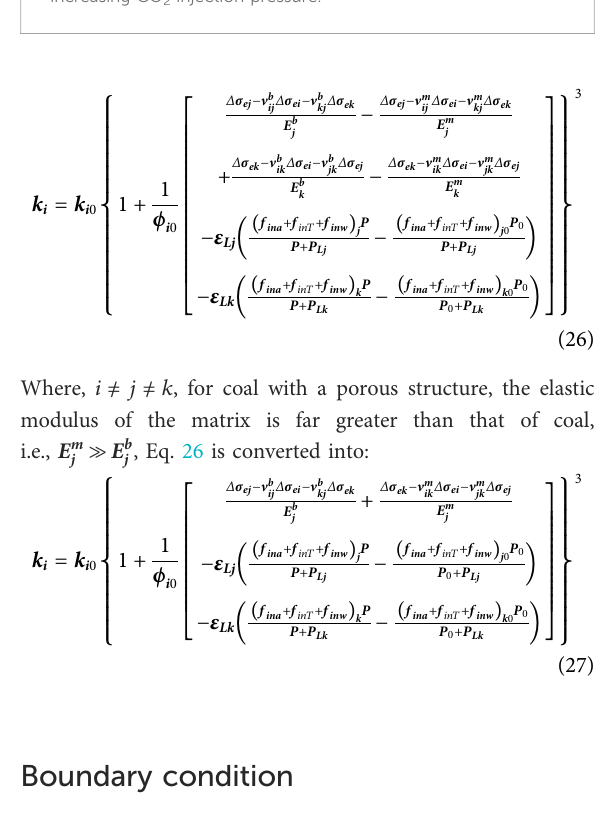
FIGURE 3 Changes in the permeability of cylinder sample with the increasing CO 2 injection